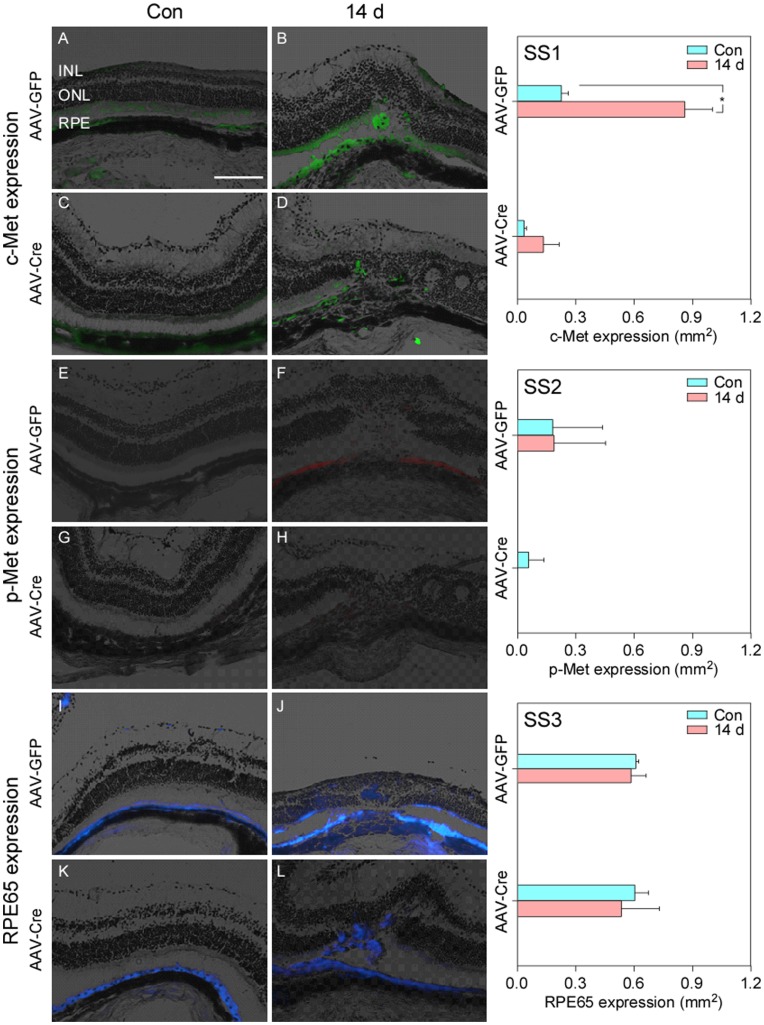
c-Met, p-Met and RPE65 expression in c-Metfl/fl mice 14 days after AAV-GFP and AAV-Cre injections, respectively (A, C, E, G, I and K) without laser burns; and after laser burns (B, D, F, H, J and L).Mice were scarified on day 14 after laser application (total day, 28). In AAV-GFP injected mice, laser burns induced an expected increase in c-Met and p-Met (B vs. A; E vs. F). There was no detectable c-Met or p-Met expression was seen after subretinal AAV-Cre injection (C and G). Less c-Met and no p-Met expressed were observed even after laser injury (D and H). RPE65 expression was not affected by subretinal injection of AAV-GFP or AAV-Cre injection (I – L). There were more migrated RPE cells in ONL in AAV-Cre injected (L) compared to AAV-GFP injected mice (J). There was very limited c-Met and p-Met detected in AAV-Cre injected eyes before and after laser injury (SS1– SS2); in AAV-GFP injected eyes, c-Met expression expectedly increased after laser treatment (SS1) (* P<0.05, independent samples t-test). RPE65 expression was not affected by either AAV-GFP or AAV-Cre injection (SS3).